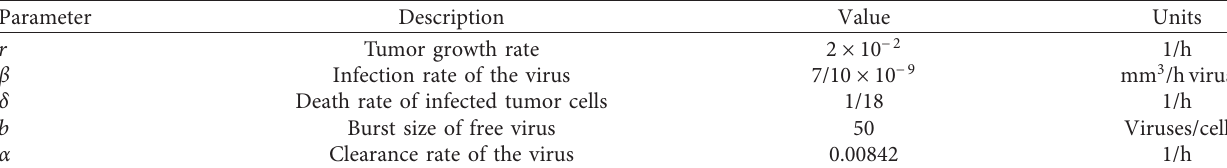
Table 1: Parameters and values for system (1) taken from [10,